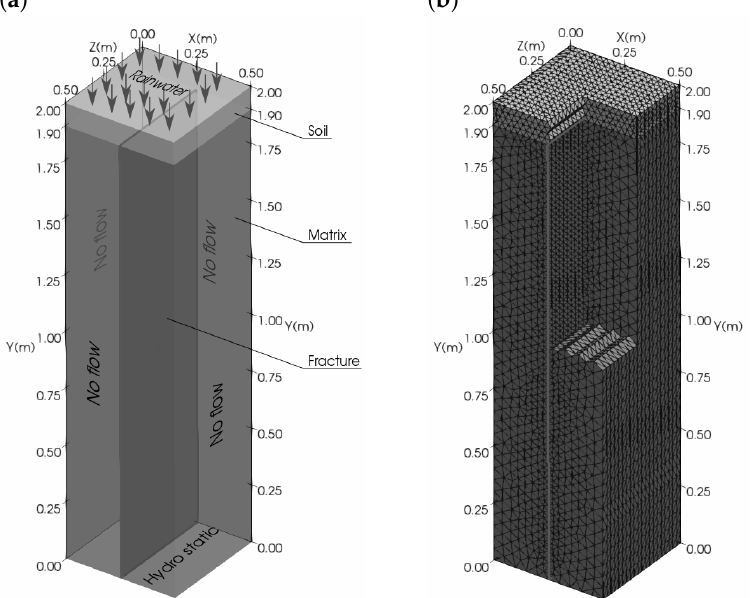
Figure 9. Model TUFF3D, a three-dimensional single-fracture version of fractured tuff model. ( a ) boundary conditions and ( b ) tetrahedral finite element mesh with split